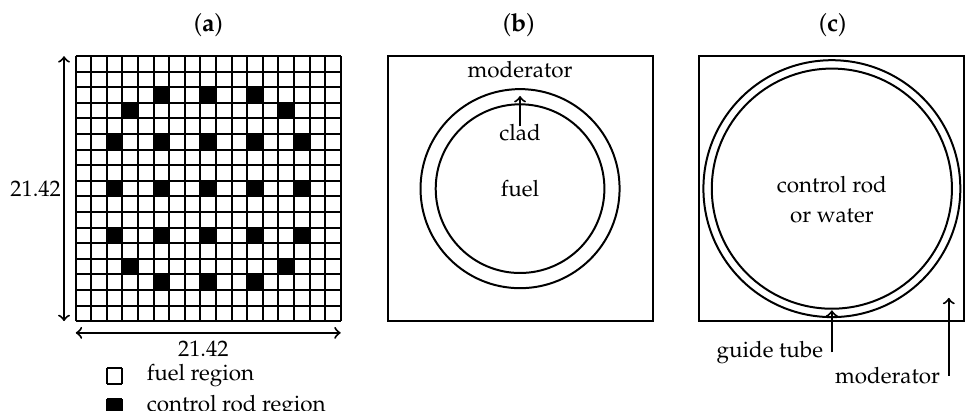
Figure 3. ( a ) The array of channels in the pressurised water reactor (PWR) fuel assembly: white boxes indicate fuel regions; black boxes indicate control-rod regions. ( b ) The fuel region has a fuel pin (uranium, enriched 2.4% U 235 ) of radius r = 0.4025cm, which is surrounded by cladding (zirconium and chromium) of width 0.0725cm and water. ( c ) The composition of the control-rod region. The control rod (boron and carbon) of radius r = 0.573cm sits inside a guide tube of width r = 0.04cm, again surrounded by water. If the rod is withdrawn, water fills the